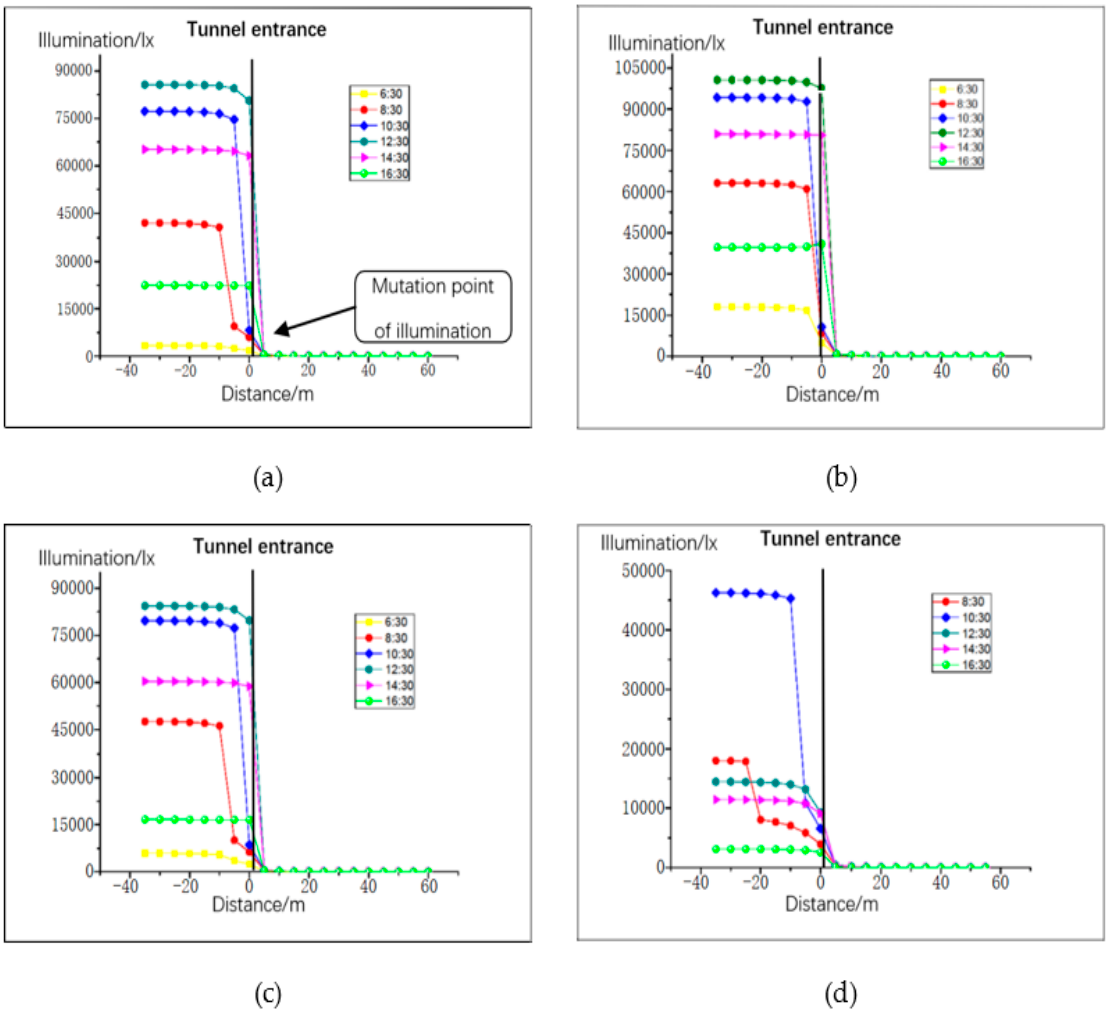
Figure 4. Road illumination for clear weather pattern: ( a ) vernal equinox, ( b ) summer solstice, ( c ) autumn equinox, and ( d ) winter solstice.